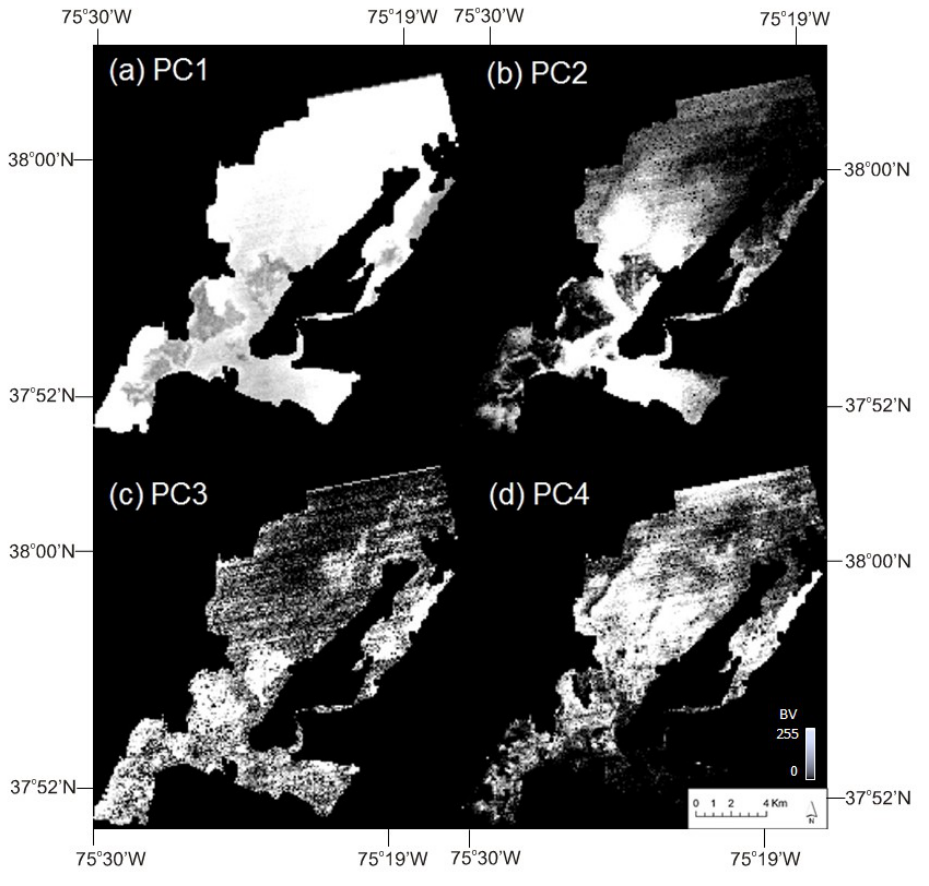
Figure 9. PCA brightness value images on normalized 8-bit range derived from time series ASTER temperature images ( a ) PC 1, ( b ) PC 2, ( c ) PC 3, and ( d ) PC